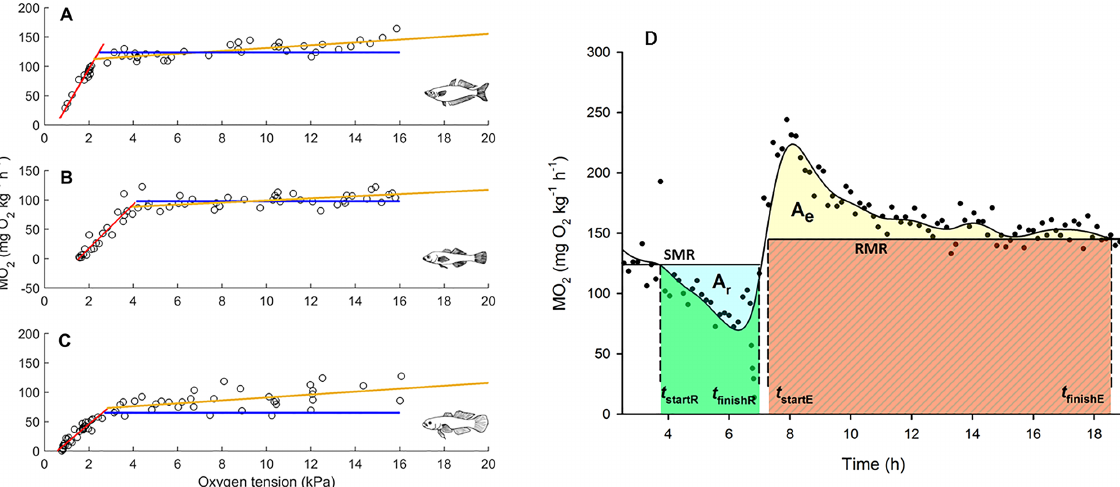
_ M _ as a function of oxygen O 2 _ M _ that defines P crit . On each plot three O 2